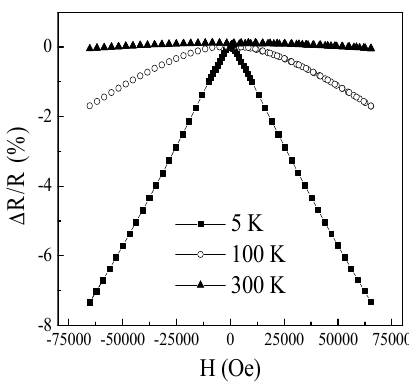
Figure 29. Magnetoresistance of the as-cast Cu 63 Fe 37 microwire with ρ = 0.31 measured at 5 K, 100 K and 300 K at magnetic field from − 70 to 70 kOe. Reproduced from reference [92], Figure 5.